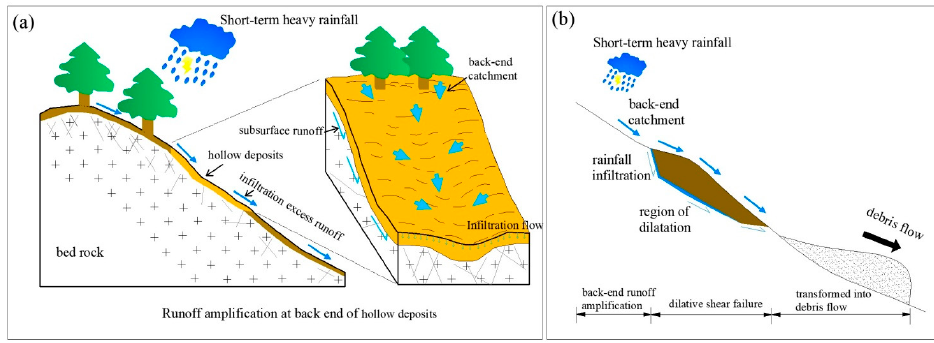
Figure 9. Process and mechanism of CDH failure. ( a ) Amplification of runoff at the back end of the hollow. ( b ) Process of destabilization of the CDH.